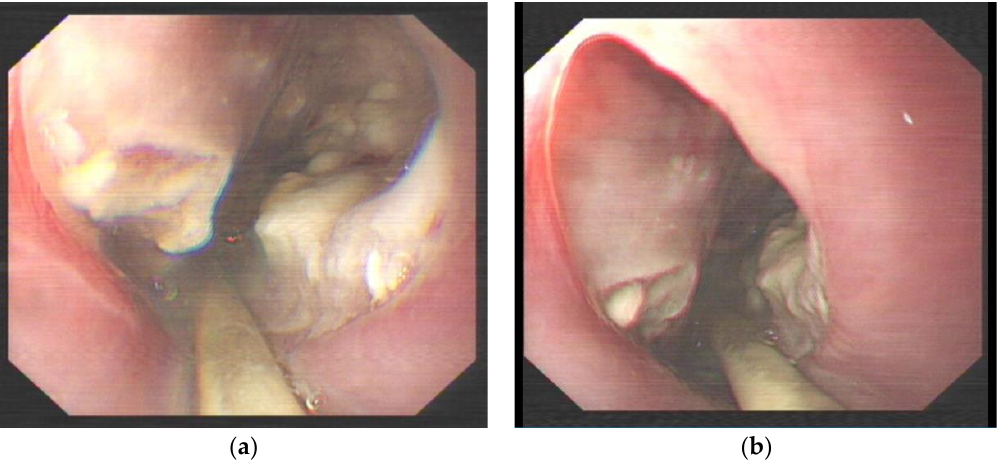
Figure 2. The esophagography shows leakage of contrast medium (white arrow), barium meal leakage, and esophageal diverticulum on the right side of the esophagus (black arrow).